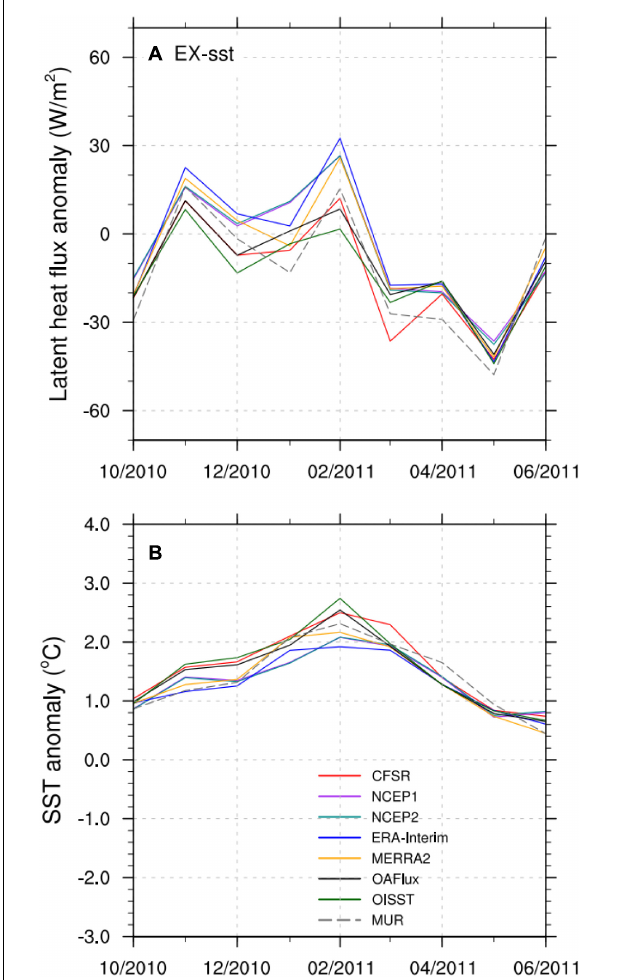
FIGURE 10 | (A) Monthly mean latent heat flux anomalies over the region (110 ◦ E-116 ◦ E, 22 ◦ S-32 ◦ S) for the 2010/2011 Ningaloo Niño event from EX-sst. Positive values indicate the warming of the ocean. (B) The corresponding SST anomalies from reanalysis products and satellite